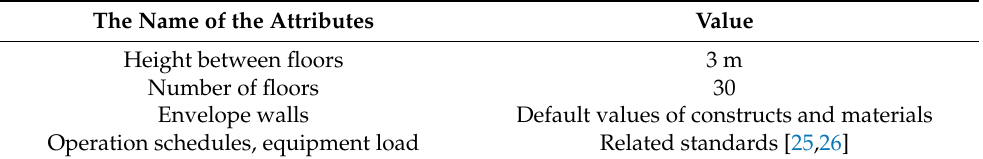
Figure 3. The laws of arrangement of each functional space. ment, and their values are provided in Table 2. After the attributes are specified, a complete 3D building model (Figure 4) can be created, which is the default model used in this study. Table 2. The value of the attributes used in the optimization process.